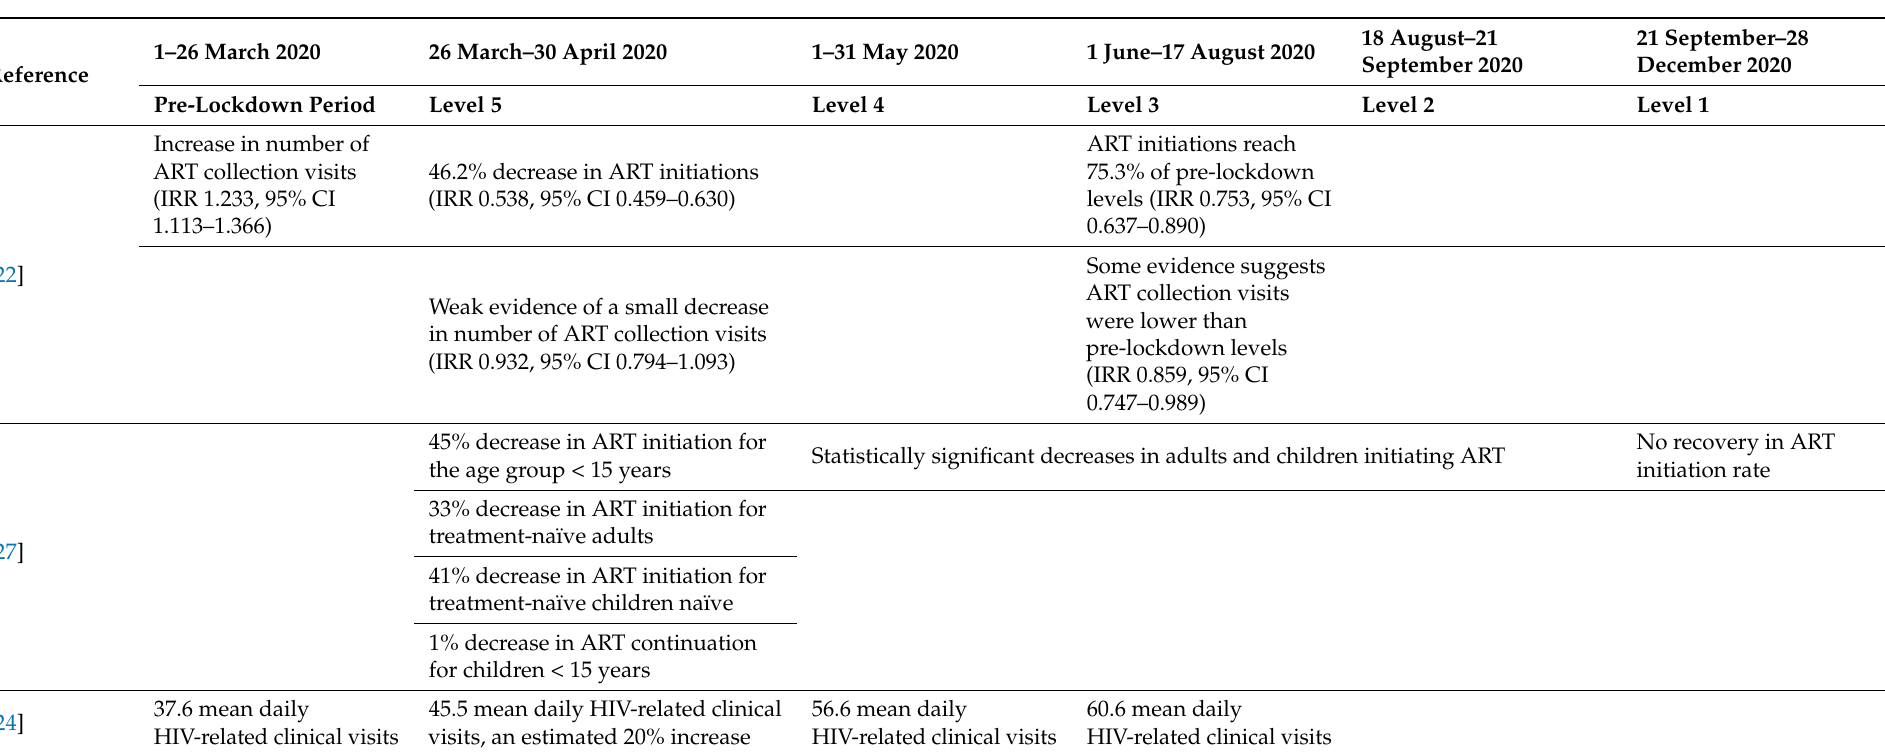
Table 4. This table summarises the changes in ART services in chronological order, from before the lockdown, to during the lockdown. Some data are in incidence rate ratio (CI 95%) or the interquartile range is given. (IQR = Interquartile Range; IRR = Incidence Rate Ratio; CI = Confidence Interval; HIV = Human Immunodeficiency Virus; ART = Antiretroviral